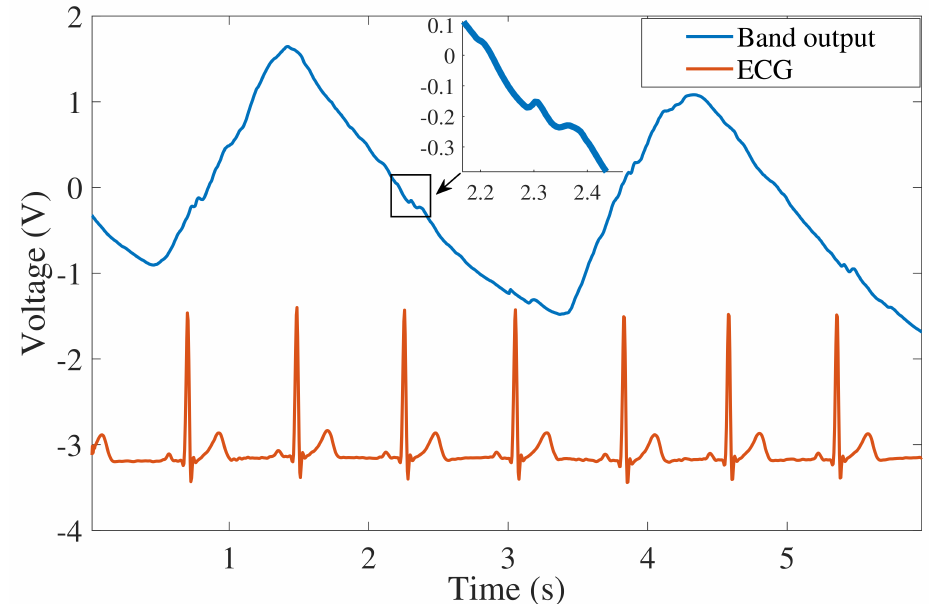
Figure 5. An example waveform from the sensor band showing the respiratory and pulse signal with corresponding ECG. Inset: zoomed-in view of the